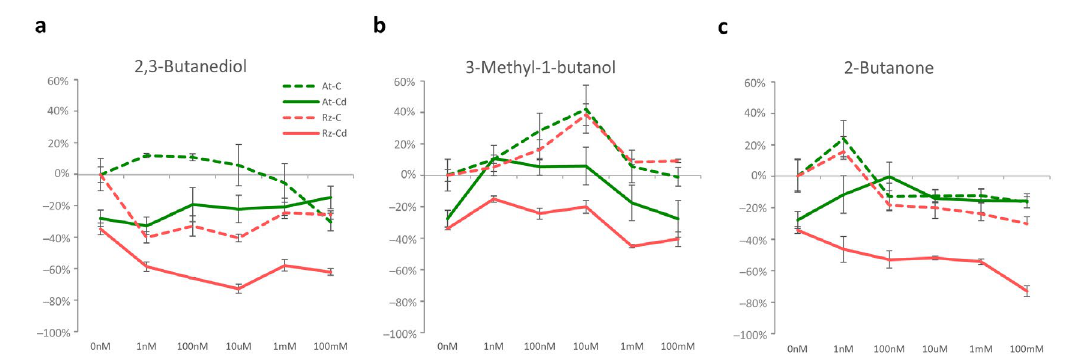
Figure 2. Growth variation relative to control (no Cd and no VOC). A. thaliana and Rhizobium were simultaneously exposed to 2 Cd conditions (0 and 100 μM) and 6 concentrations (0 nM, 1 nM, 100 nM, 10 μM, 1 mM, and 100 mM) of 2,3-butanediol ( a ); 3-methyl-1-butanol ( b ); and 2-butanedione ( c ) conditions. A. thaliana was exposed to VOC and not to Cd (green dashed line); VOC and Cd (green full line). Rhizobium was exposed to VOC and not to Cd (pink dashed line); VOC and Cd (pink full line). Values are means of 3–6 replicates + standard errors. For statistical significance, see Supplementary Table